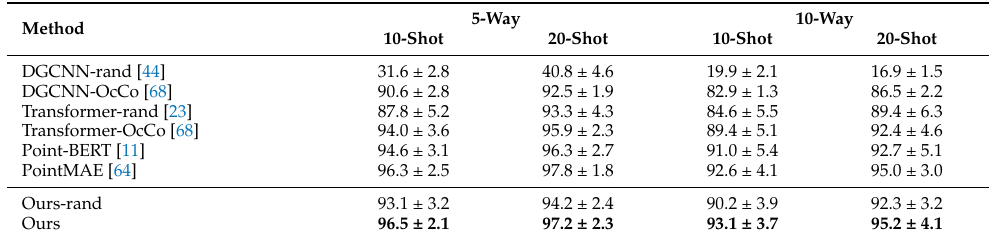
Table 8. Few-shot classification results of different methods on ModelNet40. The bold denotes the best performance.